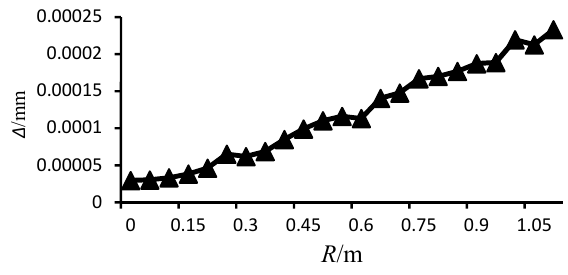
Figure 6. Maximum stress through varying tip radius of cone.